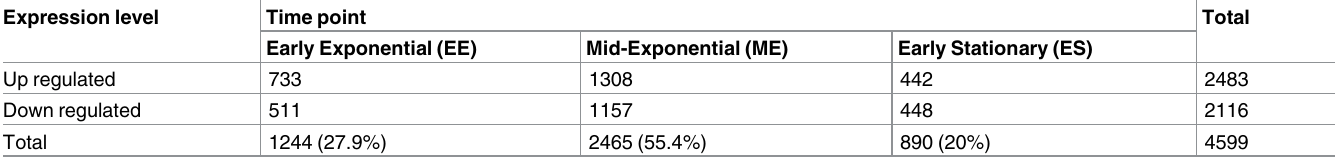
Table 1. Total genes up and down regulated in each of the three points monitored during growth of SCF1 in lignin-amended cultures. The number in parenthesis indicatesthe percentageof the genes that were differentially expressedunder each time. Expression level